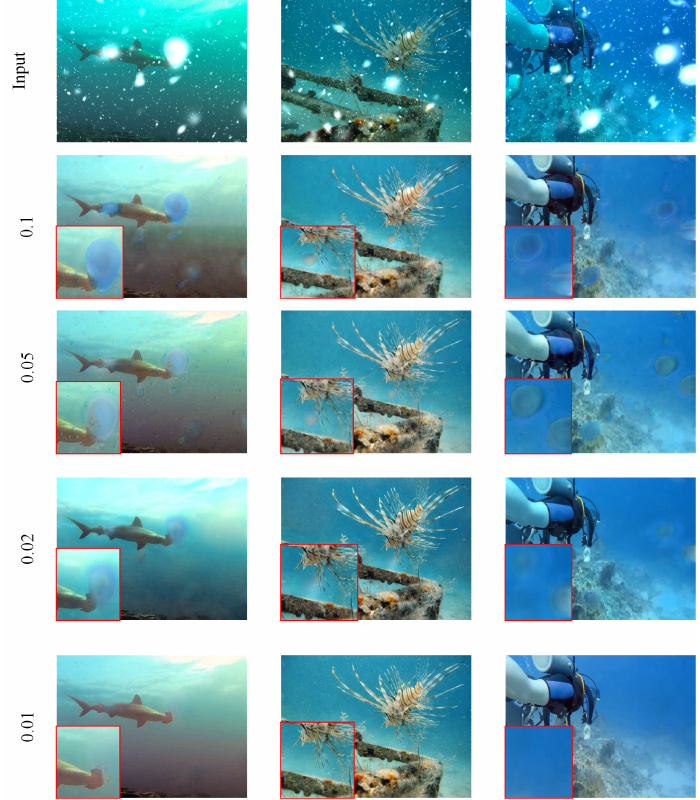
Figure 11. Ablation study of λ perctual on UIEBD-Snow